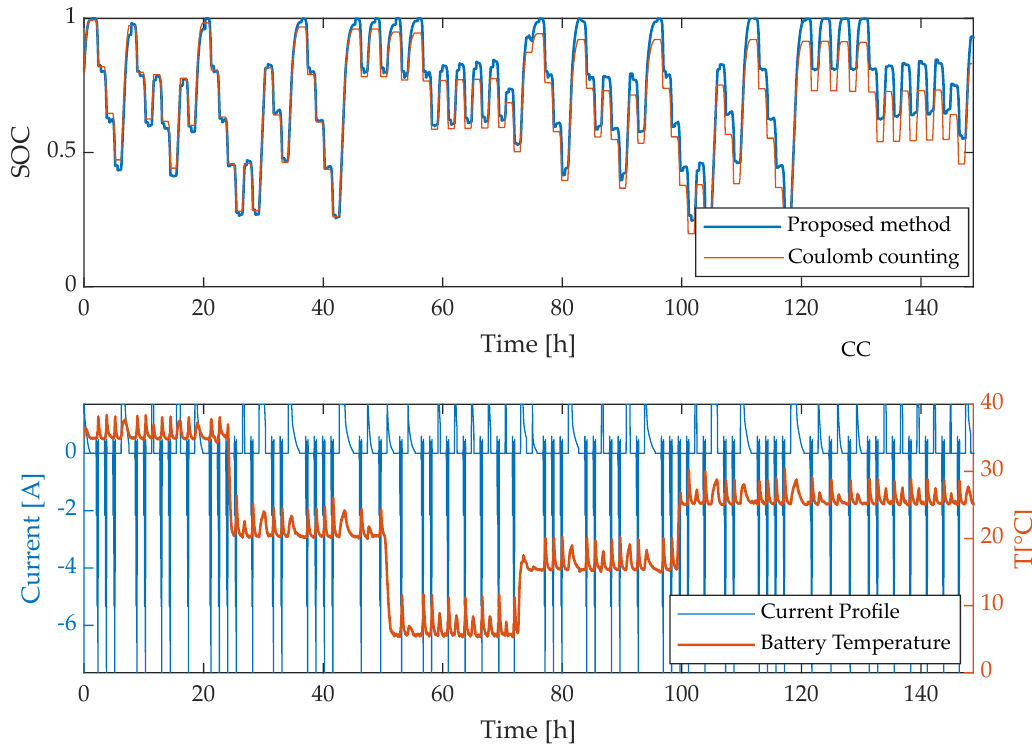
Figure 7. Verification test. SOC estimation comparison (top). Current profile and battery temperature